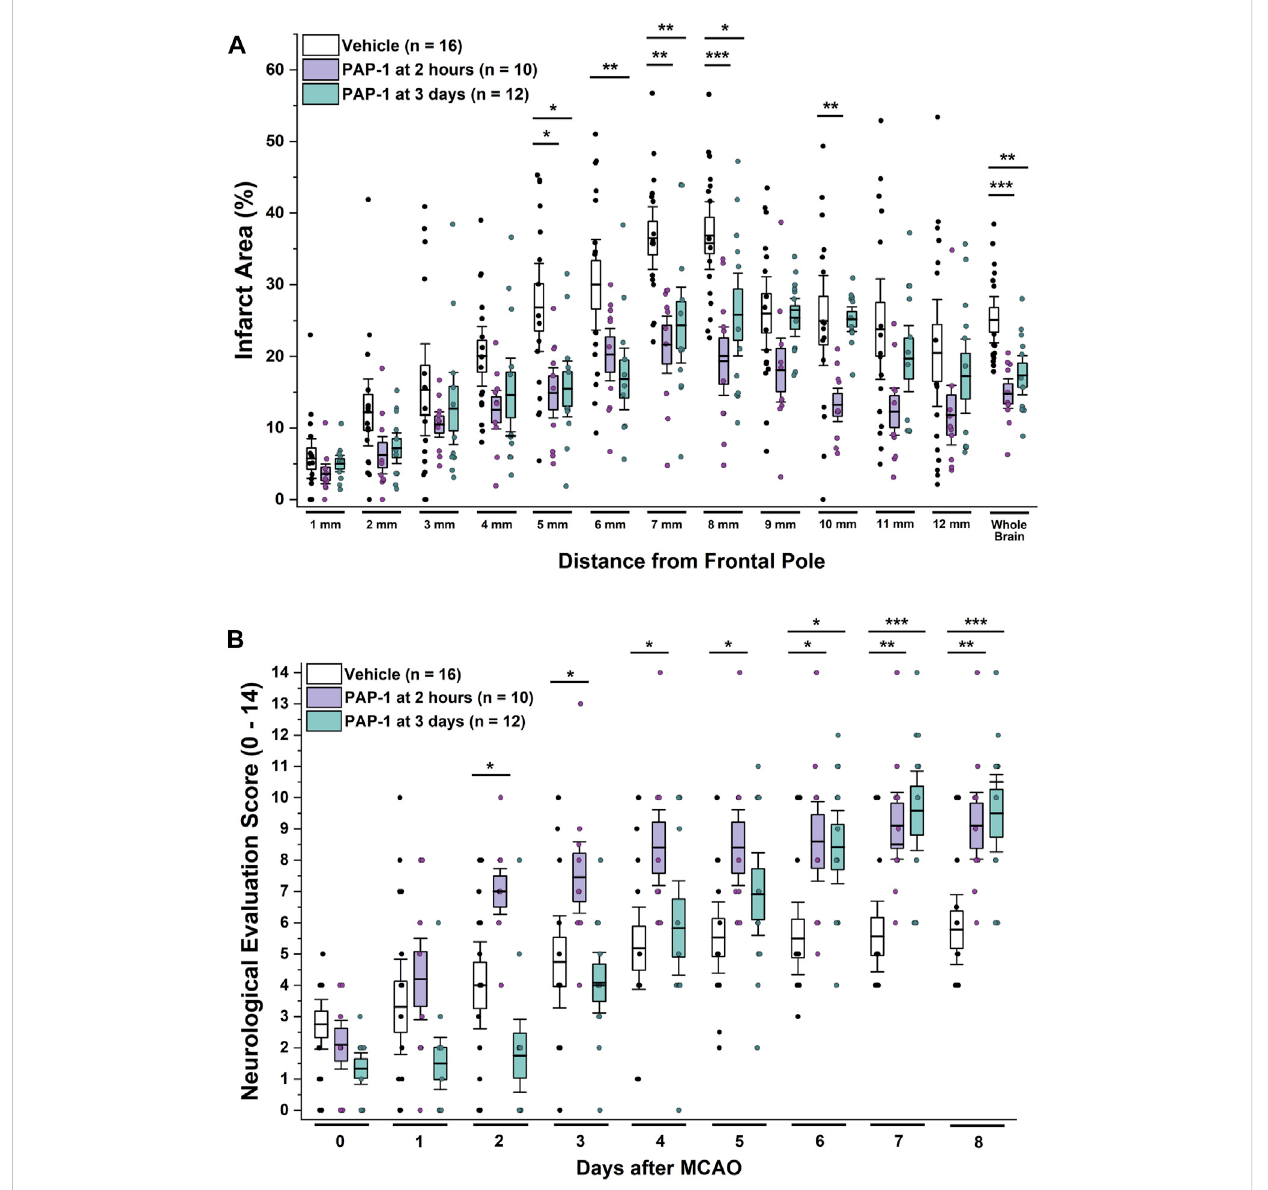
FIGURE 3 K V 1.3 inhibition with PAP-1 still improves MCAO outcomes when administration is started 3 days after reperfusion. (A) Infarct area and (B) neurological de fi cit score in vehicle treated male Wistar rats (n = 16) compared to animals treated with 40 mg/kg PAP-1 started at 2 h (n = 10, p = 0.0004 for infarct, p = 0.005 for NES on day-8) or started at 3 days (n = 12, p = 0.005 for infarct, p = 0.0009 for NES on day-8)after reperfusion. Data are shown as whisker plots with data from individual animals overlayed as scatter. The boxes show mean ± S.E.M; the whiskers show con fi dence intervals. PAP-1 started at 2 h was not signi fi cantly different from PAP-1 started at 3